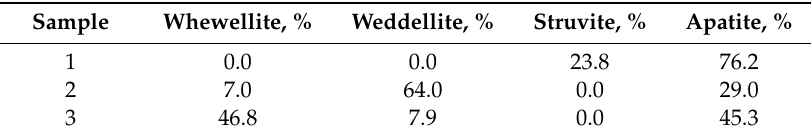
Table 2. Mineral composition of the studied kidney